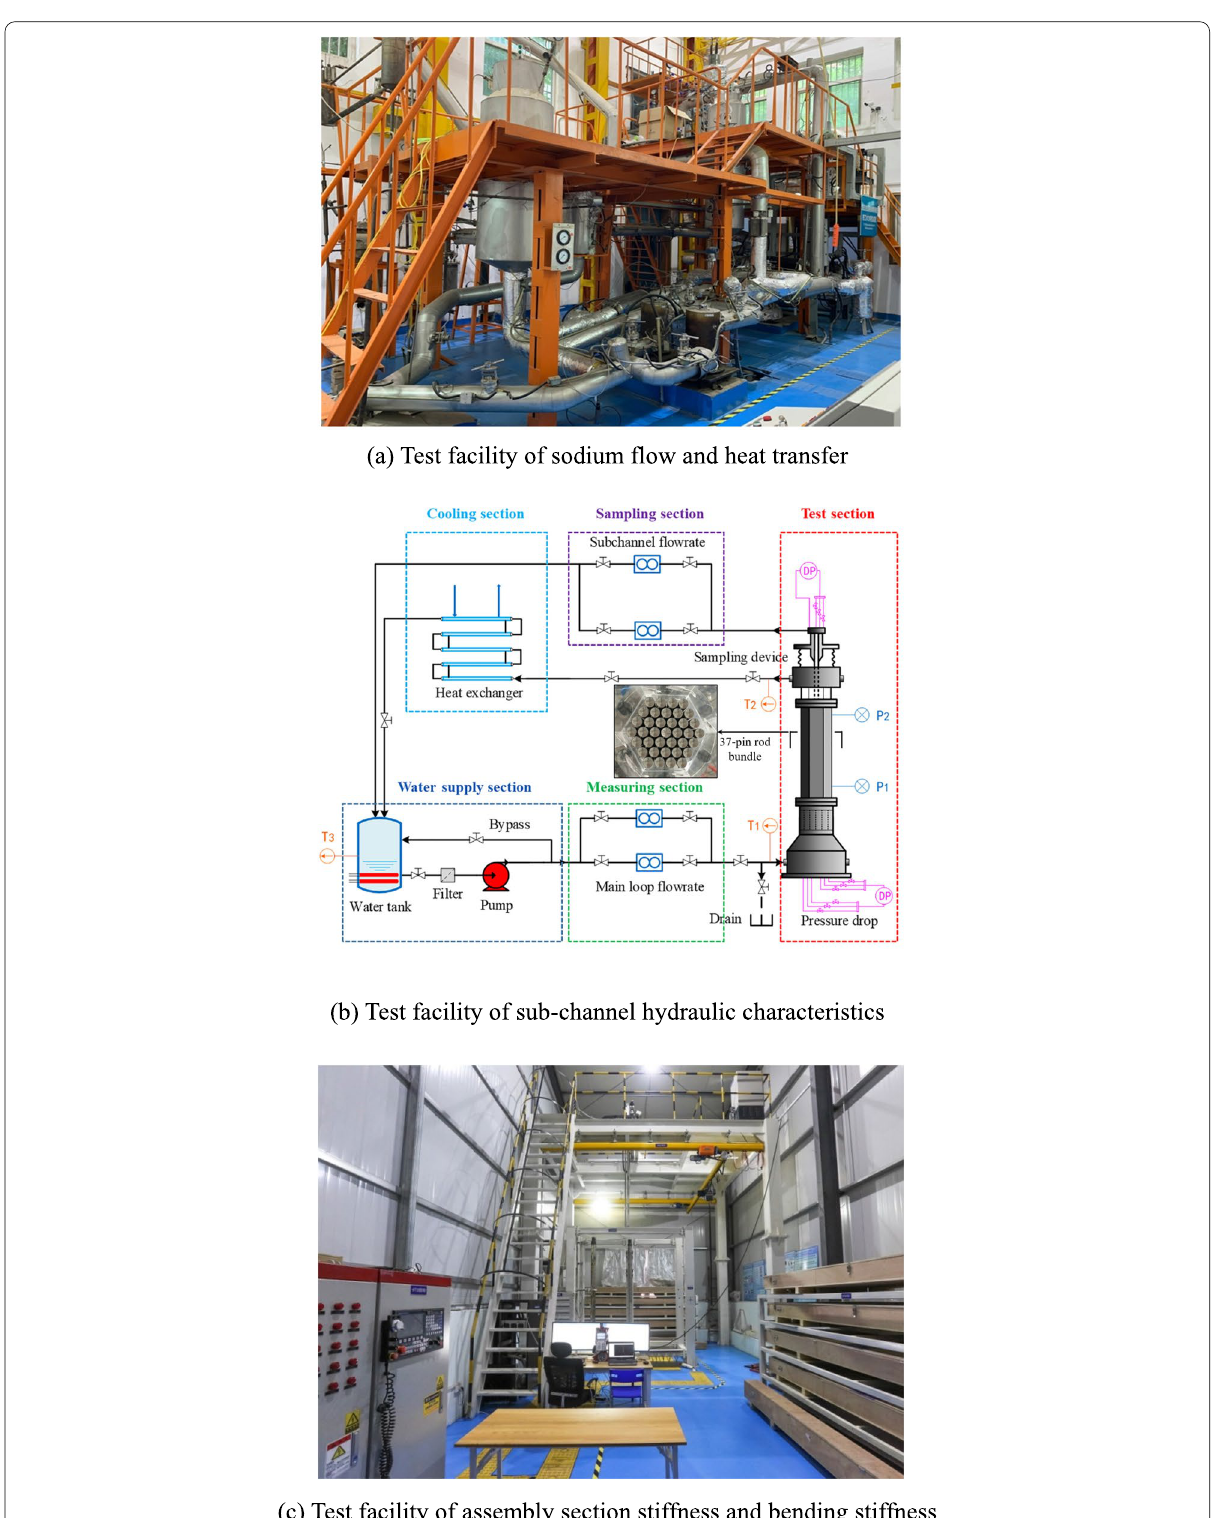
Fig. 6 Test facilities for SFR. a Test facility of sodium flow and heat transfer. b Test facility of sub-channel hydraulic characteristics [50]. c Test facility of assembly section stiffness and bending